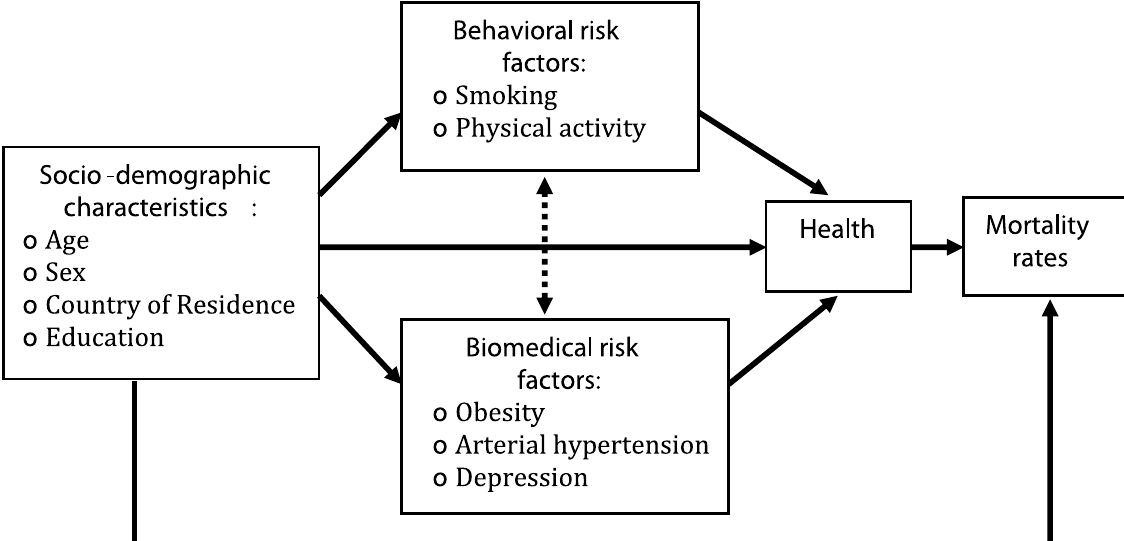
Figure 1. Schematic representation of the interaction among socio-demographic characteristics, risk factors, health and mortality in the ATHLOS-Mic’s health module.